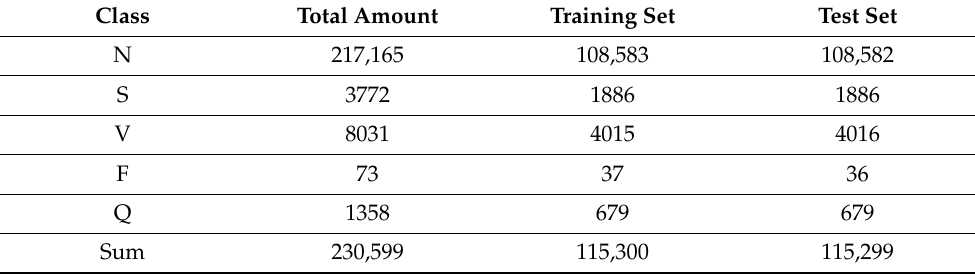
Figure 3. The samples of five heartbeat categories in the CPPDB. The background stands for a standard ECG paper and a small box represents 40 ms on the interval and 0.1 mV on the amplitude. Table 4. Data distribution of the CPPDB